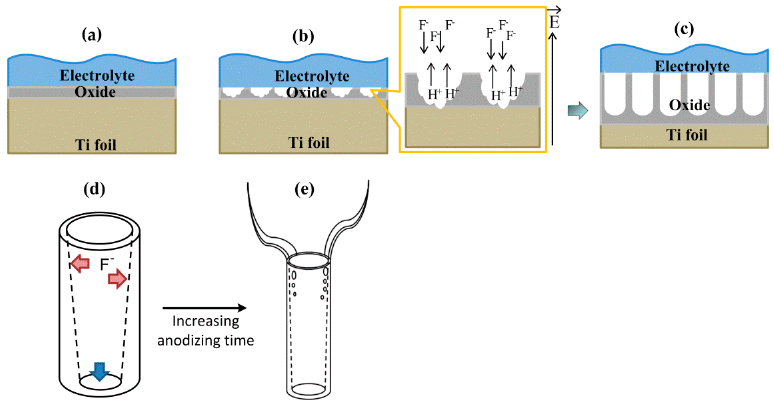
Figure 3. The growth process of TiO 2 nanotube arrays (TNAs): ( a ) non-conductive thin oxide layer forming, ( b ) local growth of the pits, ( c ) growth of the semicircle pores and developed nanotube arrays, ( d ) The shape and wall thickness profile of TNAs prior to the emergence of nanowires (TNWs), ( e ) Schematic of the TNWs/TNAs structure.